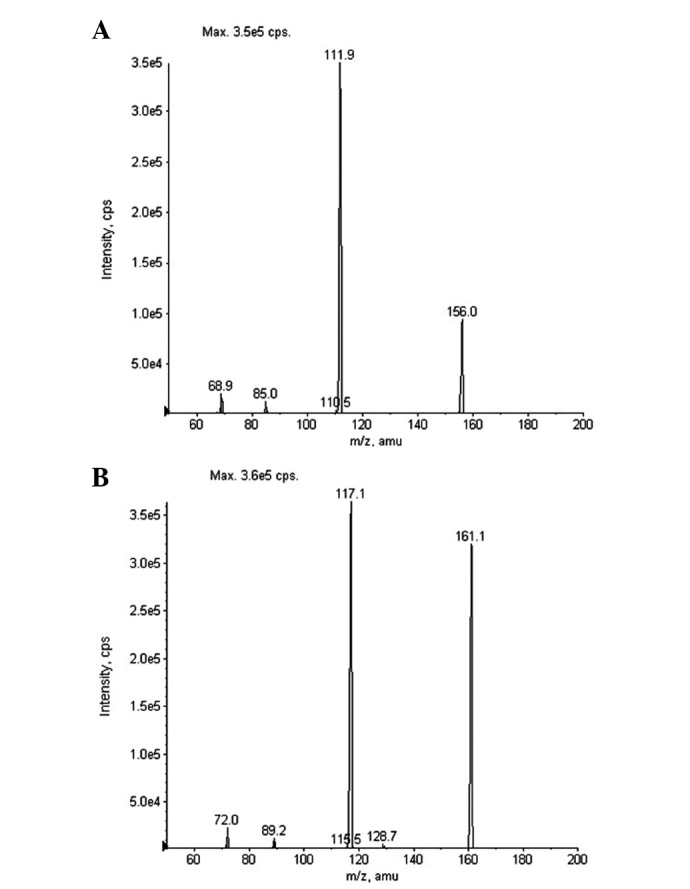
Full-scan product ion scans of [M–H]− ions for (A) Oxo and (B) [13C2,15N3]-Oxo (IS). Oxo, potassium oxonate.